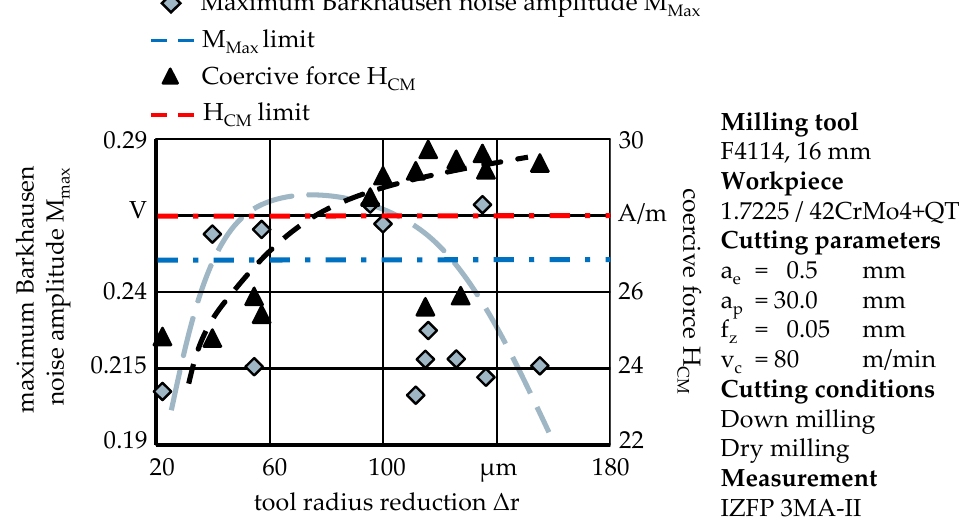
Figure 3. Development of MM at increasing tool radius reduction Δ r for constant cutting parameters.